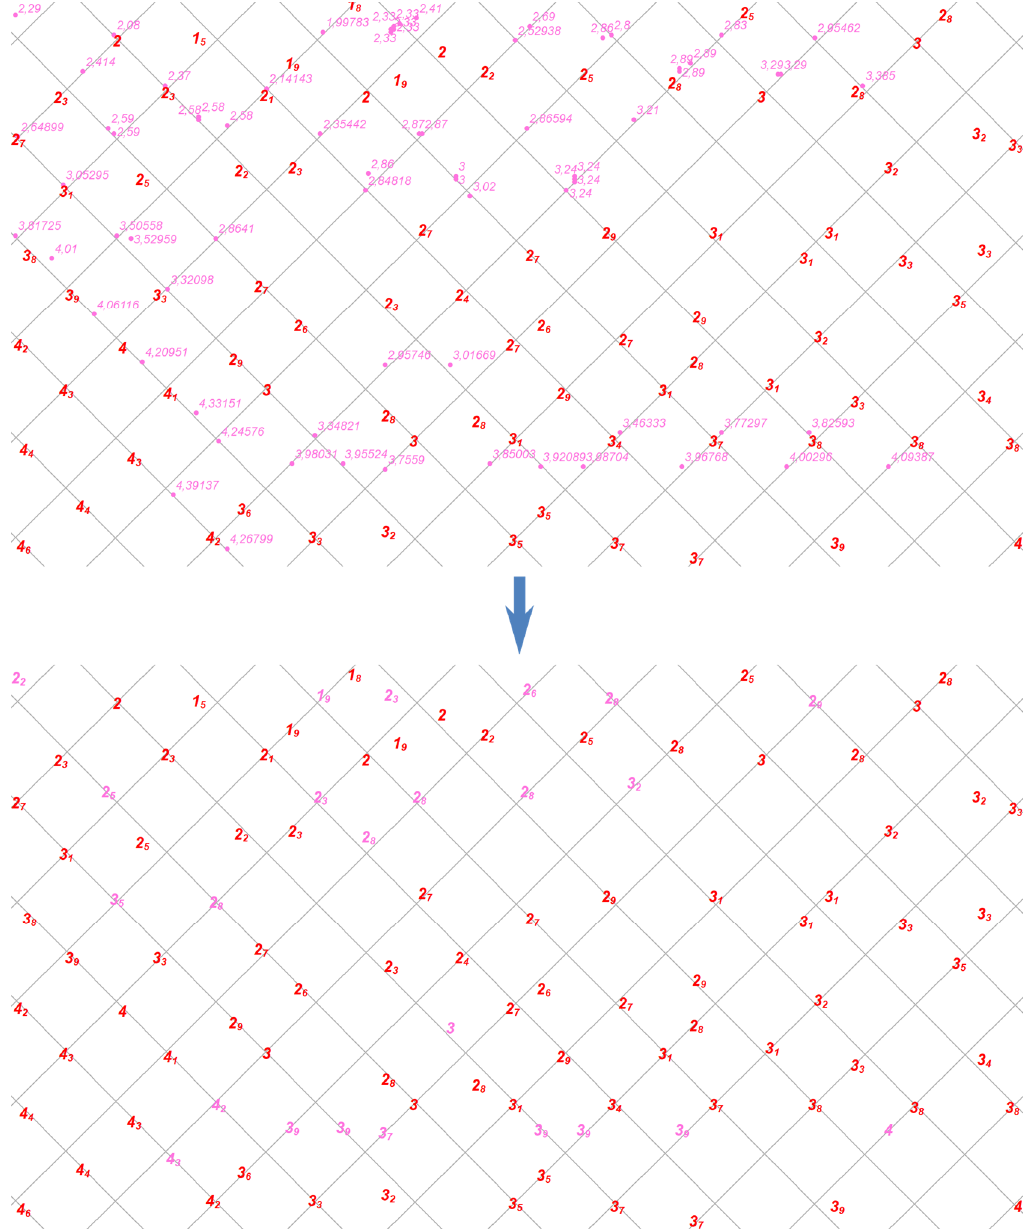
Figure 3. Prime Soundings (deeps) selection (pink—Prime deep, red—Prime shoal): (top image) selected soundings based on deep criteria and (bottom image) retained soundings based on distance criteria.